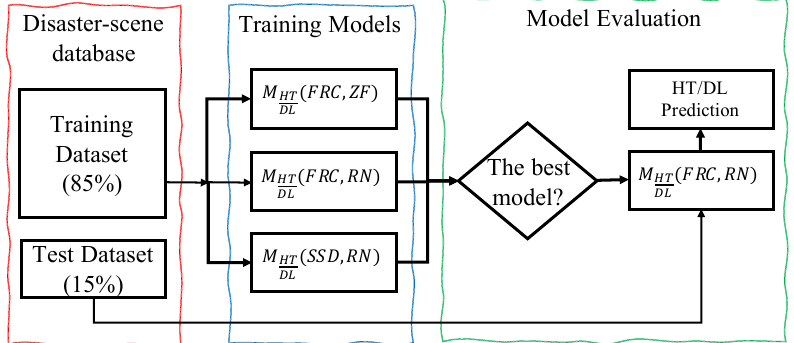
Figure 1. Workflow of proposed methodology